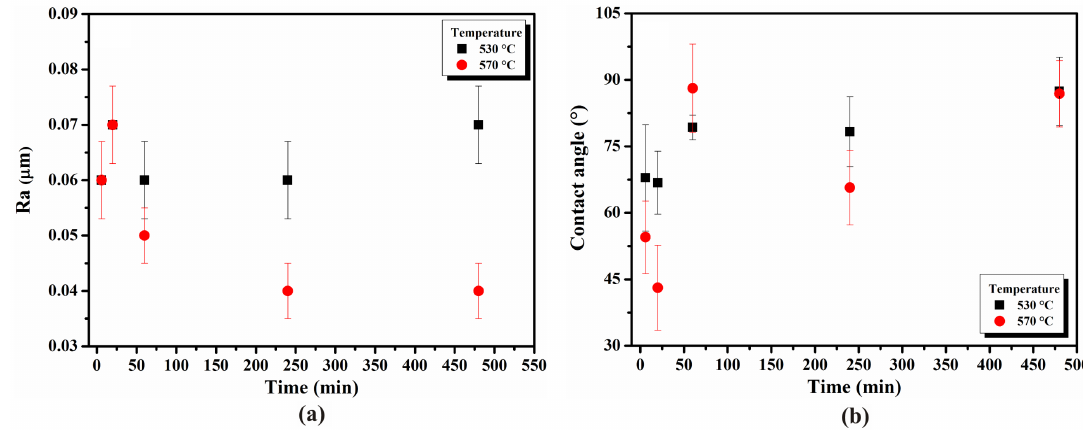
Figure 7. Roughness values (a) and contact angle (b) of the surface of the NiTi samples after exposure to different